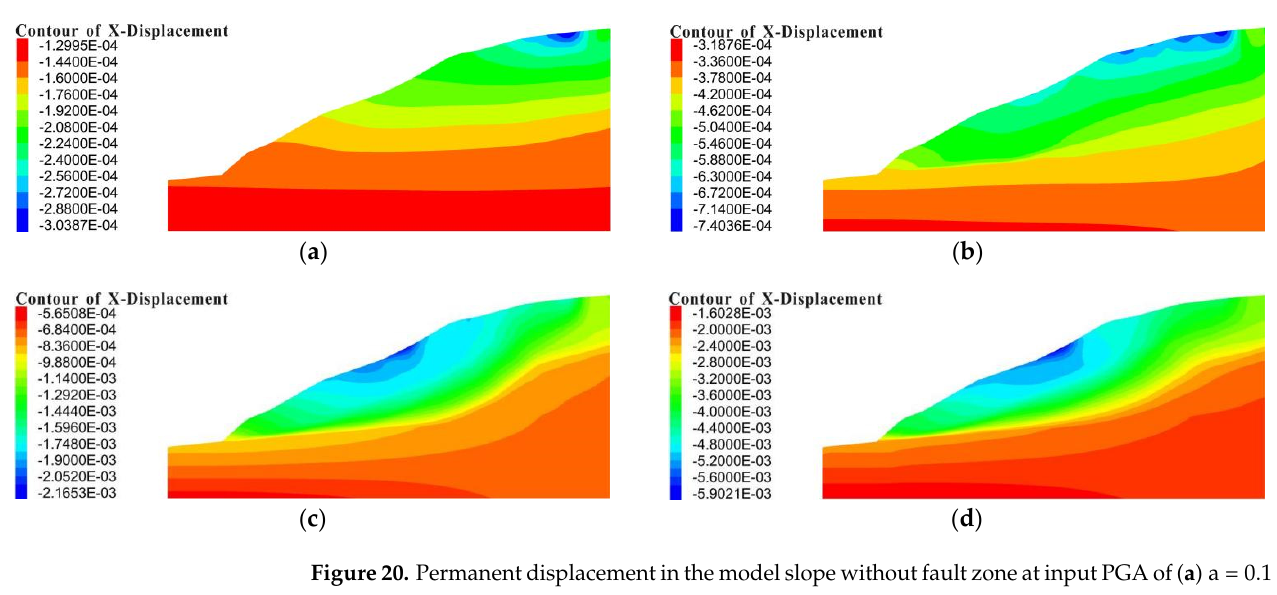
Figure 20. Permanent displacement in the model slope without fault zone at input PGA of ( a ) a = 0.1 g, ( b ) a = 0.2 g, ( c ) a = 0.3 g, and ( d ) a = 0.4 g (unit: m). ( b ) a = 0.2 g, ( c ) a = 0.3 g, and ( d ) a = 0.4 g (unit: